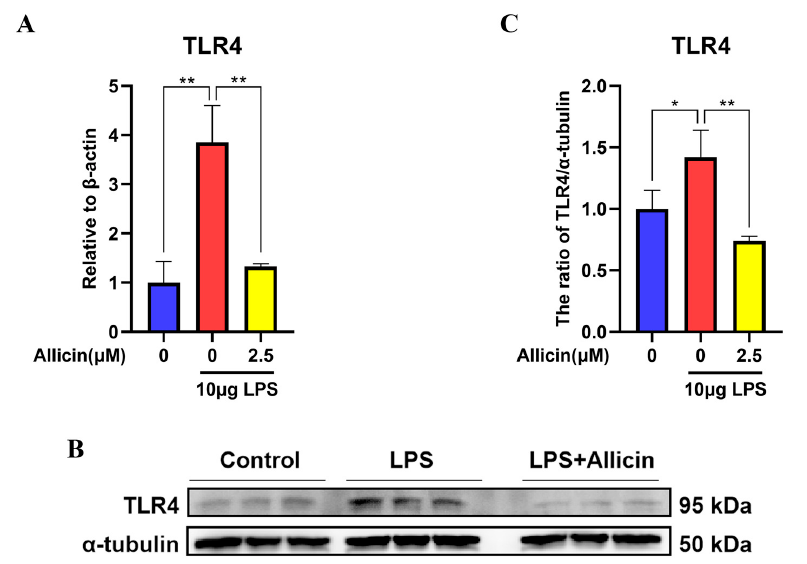
Figure 3. Effect of allicin on TLR4 expression in MAC-T cells. ( A ) The TLR4 mRNA level in MAC-T cells was detected using RT–qPCR with β -actin used as an endogenous control. ( B , C ) Expression levels of the TLR4 protein were detected using Western blotting, and α -tubulin was used as a control. *, p < 0.05; **, p < 0.01.